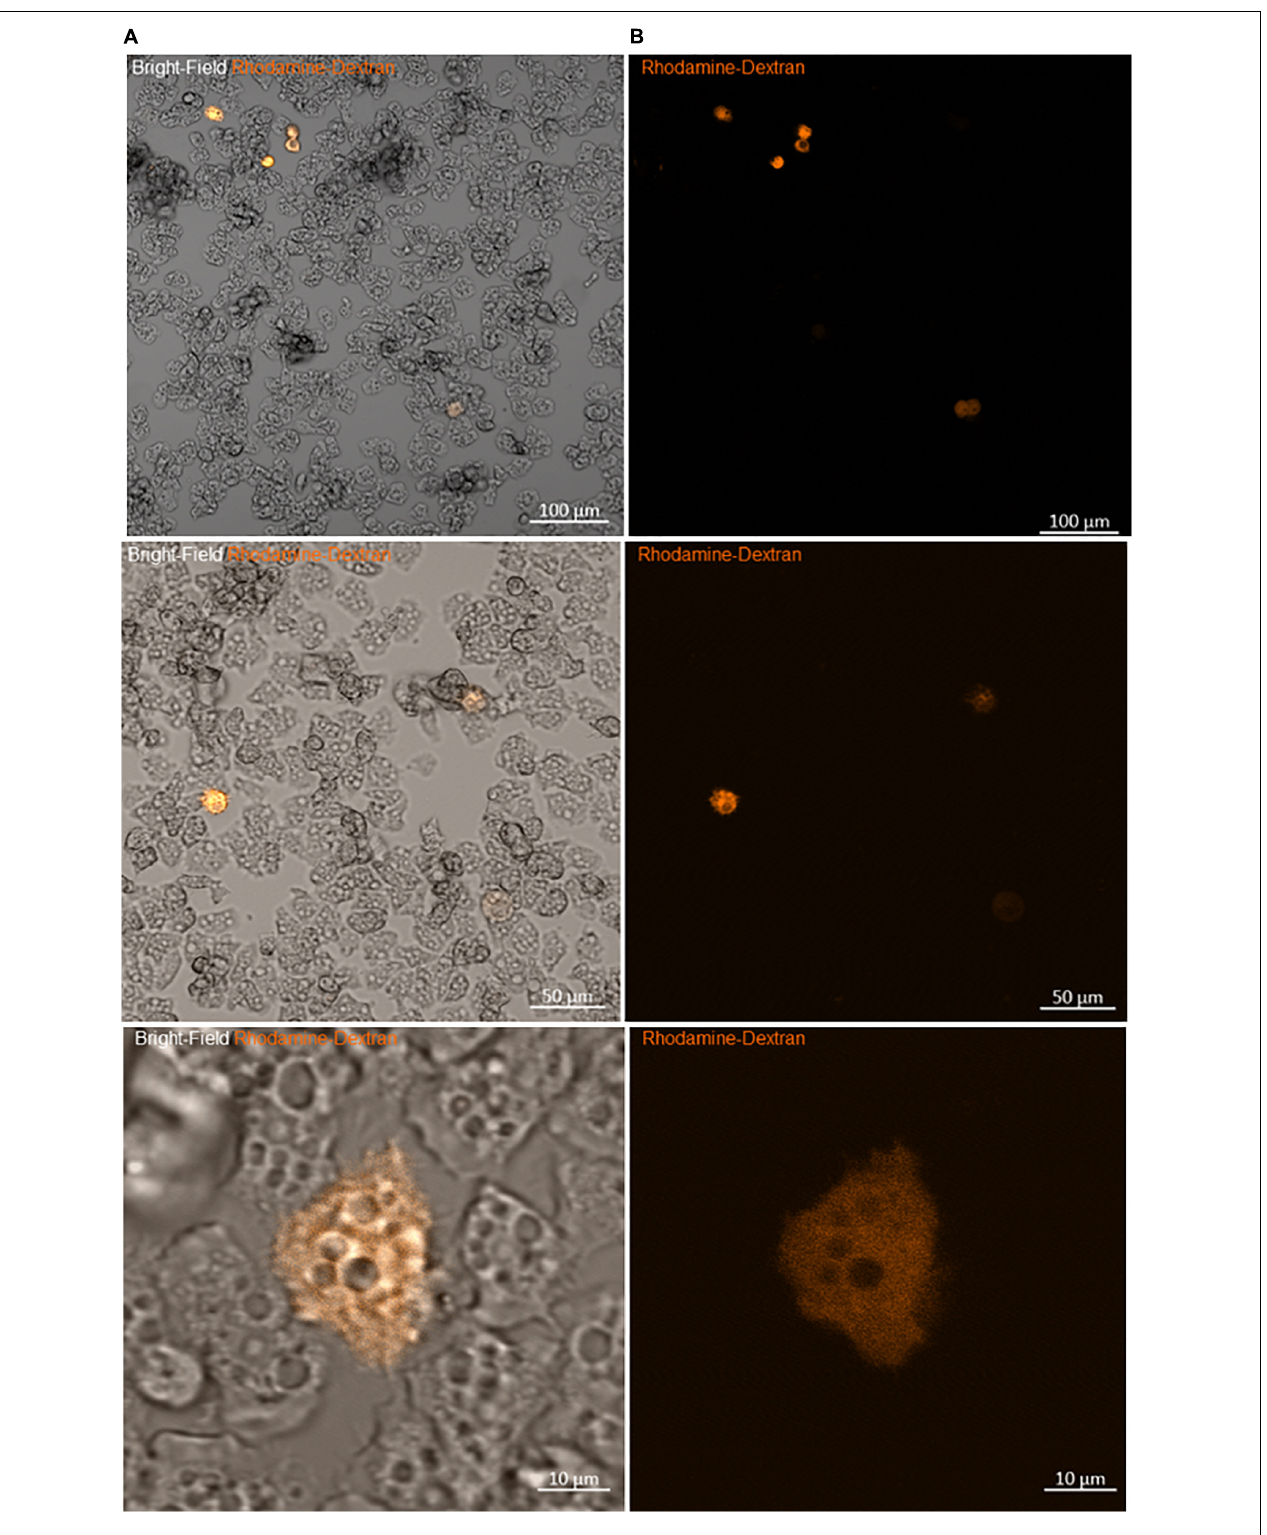
FIGURE 3 | Viability of amoeba microinjected with rhodamine-dextran dye. (A) Bright-field images showing the maintenance of the trophozoite state of different amoebae 2 h after microinjection. (B) Fluorescence microscopy images of the same frame show the homogeneity of the red dye into the cytoplasm, without any captation by other structures, sign of the successful entry of DNA and the success of the microinjection.